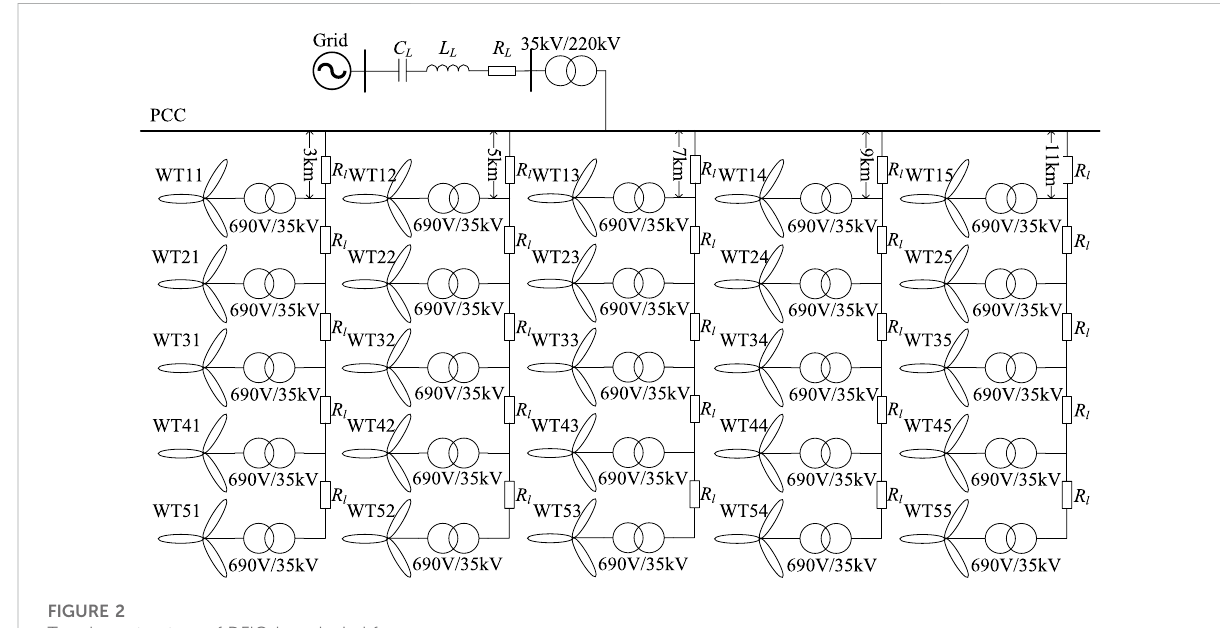
FIGURE 2 Topology structure of DFIG-based wind farm.